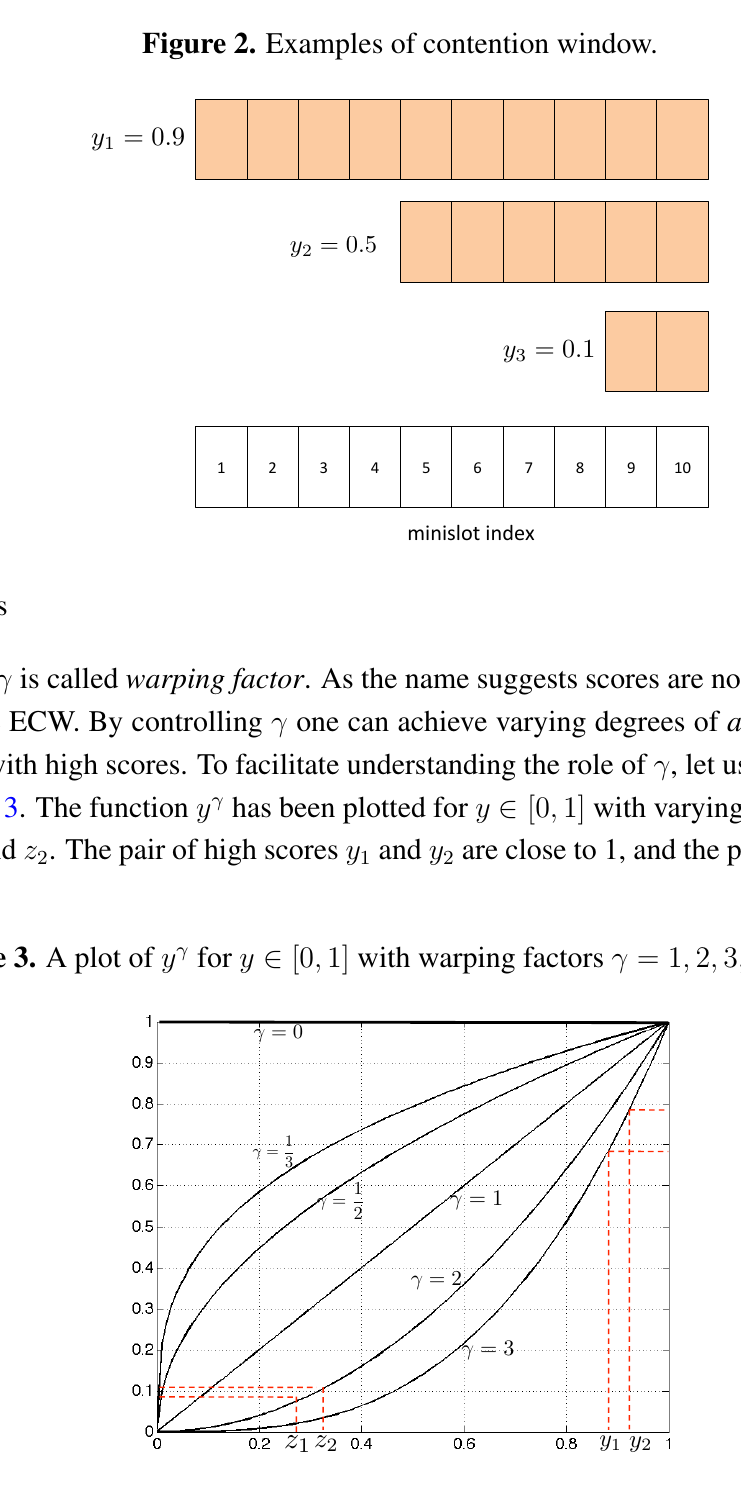
Figure 2. Examples of contention window.